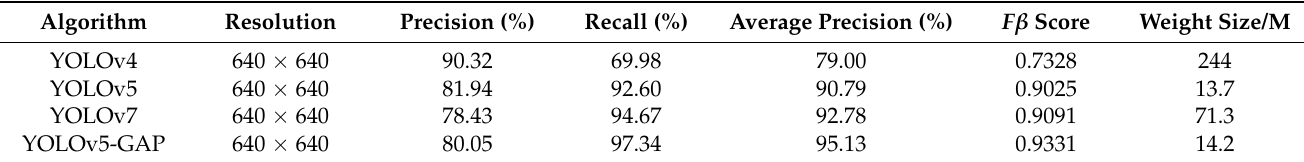
Table 4. Performance comparison of different detection